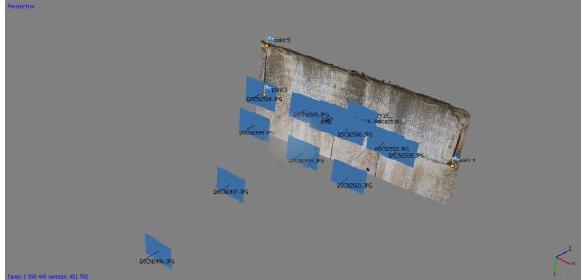
Figure 5. Inscription: elaboration in Agisoft Photoscan.